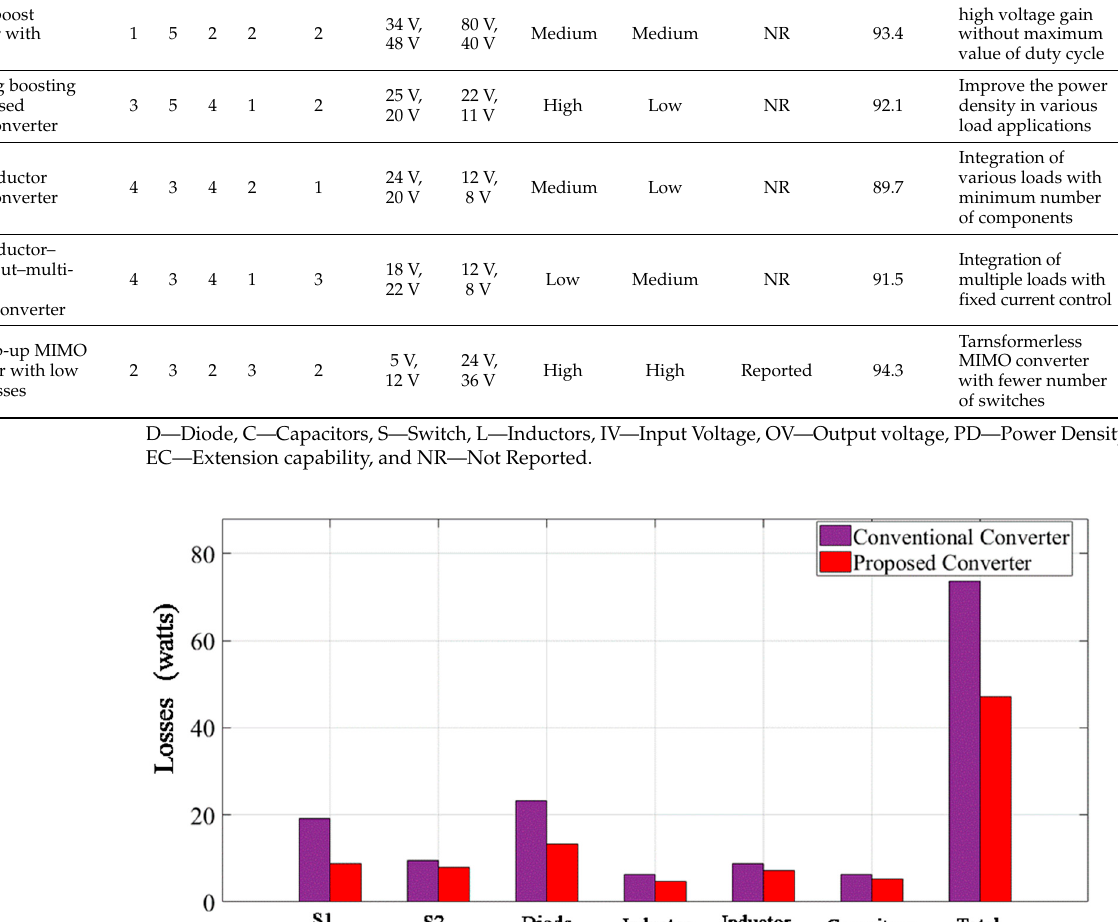
Figure 21. Power versus efficiency graph. 6. Conclusion s This work developed a transformerless and non-isolated rapid step-up MIMO DC– DC power converter with low power losses. The proposed converter is suitable for energy storage applications since it simply has two switches. Because the proposed converter runs in just two operational modes throughout each duty cycle, the converter’s control technique is simple. The performance concepts, theoretical voltage or current assessments, and steady-state analysis have been described. Furthermore, the proposed converter has two voltage gains for the first and second outputs. To ensure that the proposed converter works properly, it was compared to several different topologies. According to the